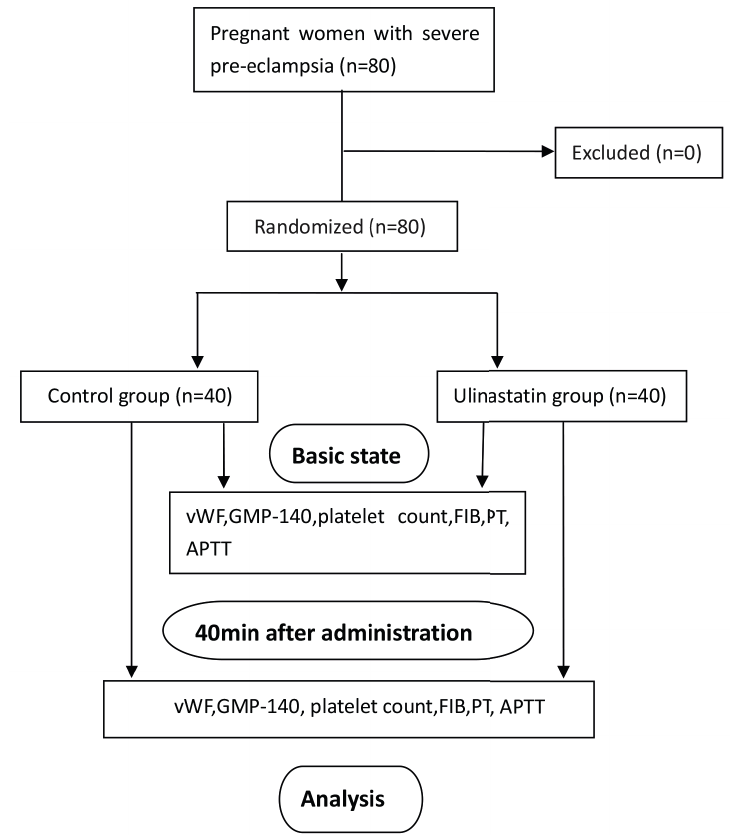
Figure 1 - Flow diagram of patient